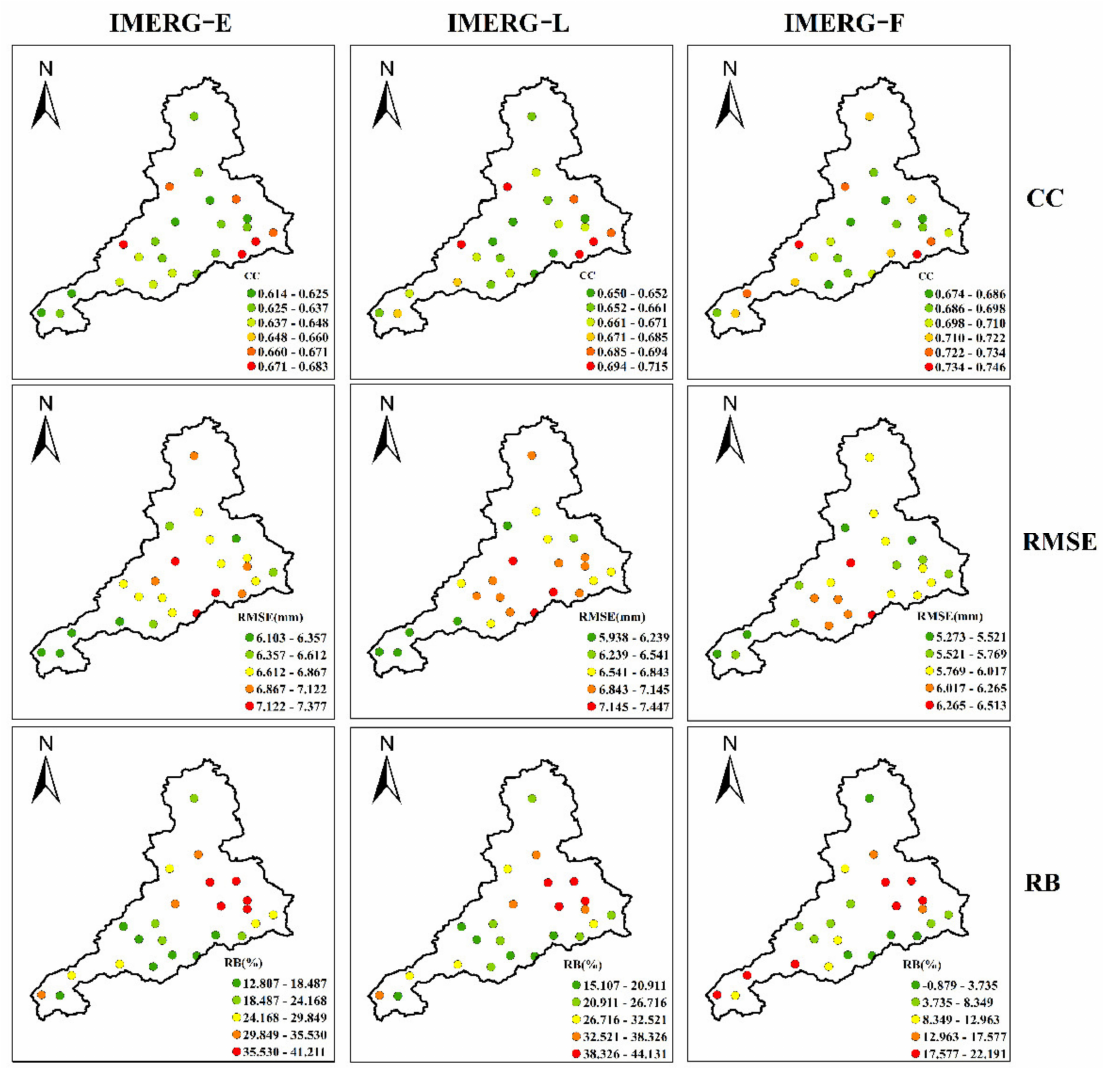
Figure 5. Spatial distributions of continuous verification statistics (CC, RMSE, RB) for IMERG